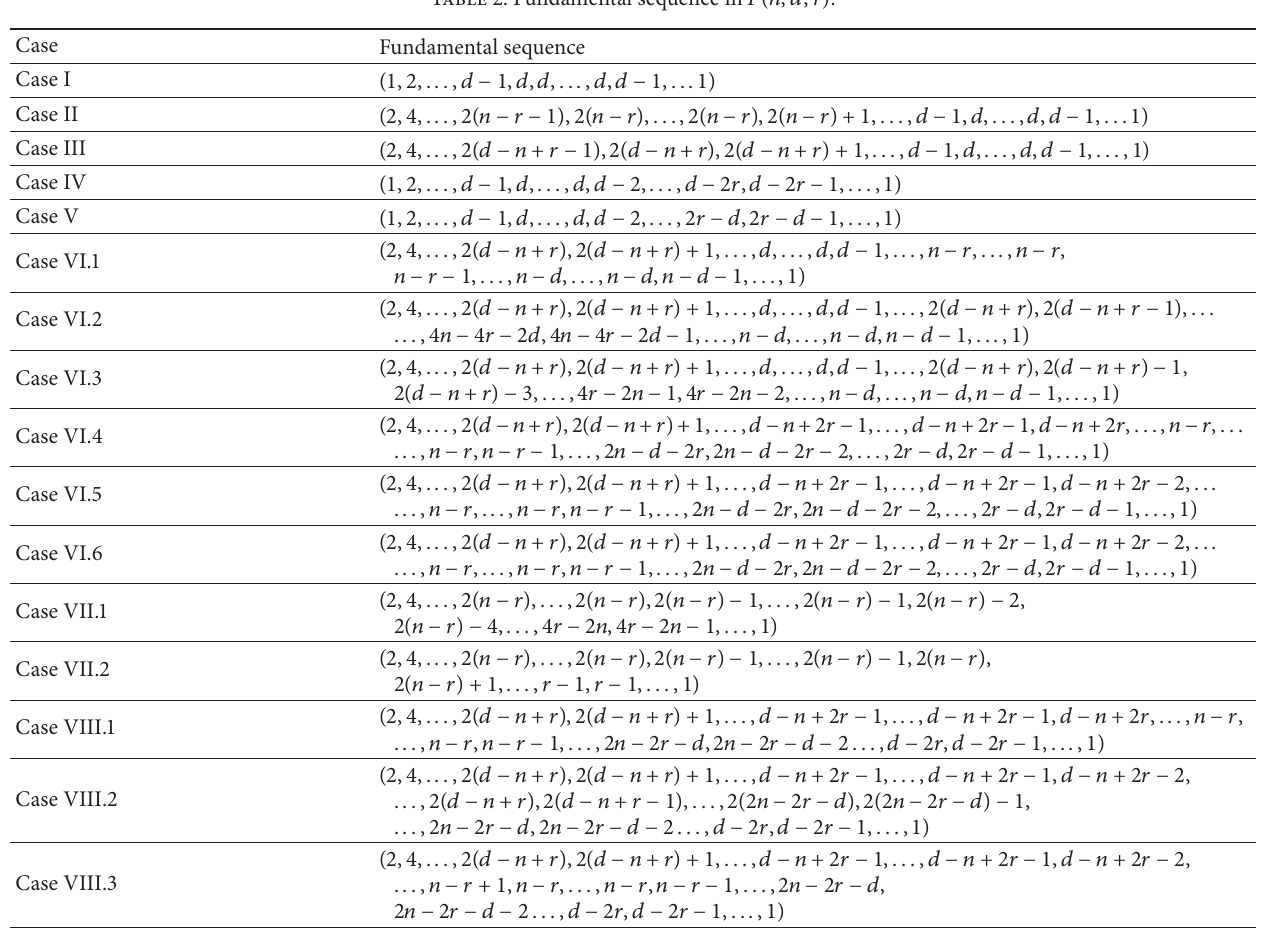
Table 2: Fundamental sequence in 𝑃(𝑛 , 𝑑 , 𝑟)